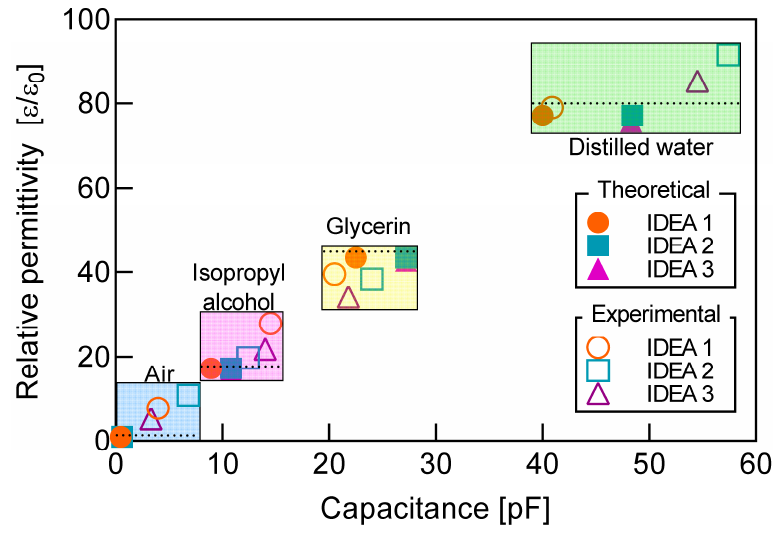
Figure 14. Relative permittivity estimations from experimental capacitance measurements and theoretical calculations for the three IDEAs 1, 2, and 3. Dotted line indicates the standard value for each testing fluid.